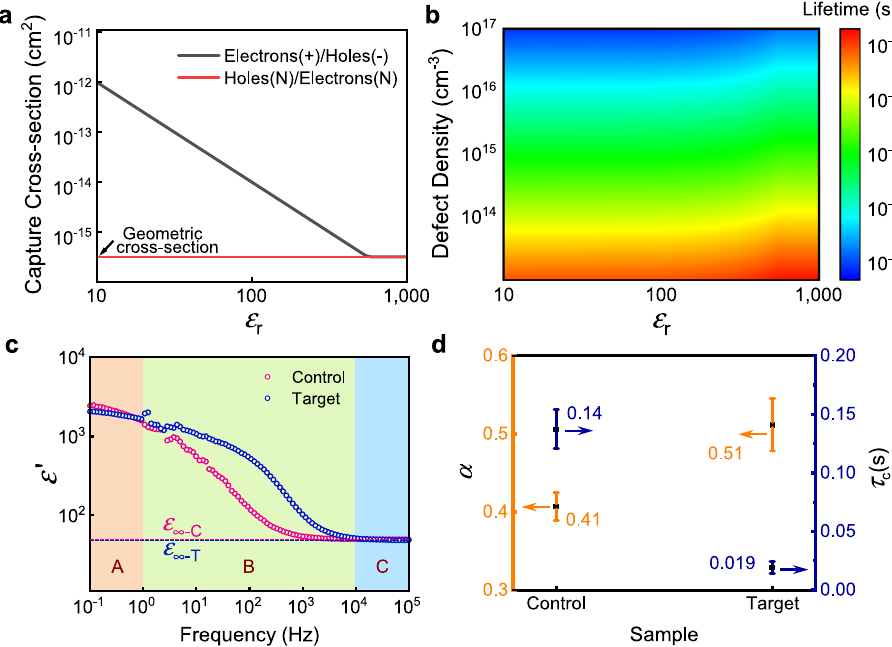
Fig. 1 Defect-related dielectric properties in perovskite fi lms. a Dielectric-dependent defect capture cross-sections of charge carriers. The electrical properties of the corresponding defects that capture the carriers are also shown. “ Plus ” means positively charged defects, “ minus ” means negatively charged defects and “ N ” represents neutral defects, respectively. b Impacts of dielectric constant and defect density on the carrier lifetime in the high- injection limit. c The real part of dielectric constant for perovskite fi lms as a function of frequency: range A (low frequency), range B (moderate frequency), and range C (high frequency). d Fitting results of frequency-dependent dielectric constant for perovskite fi lms based on the Cole-Cole equation, where parameter τ c is the relaxation time constant, and α re fl ects the width of relaxation time distribution. The error bars stand for the con fi dence interval (CI) with 95% con fi